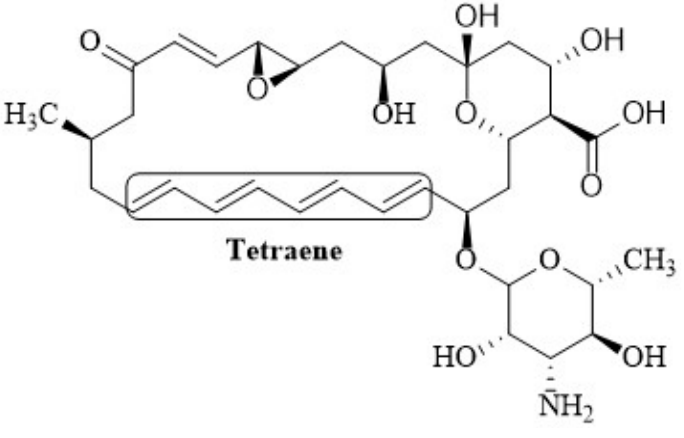
Figure 5. Structure of Natamycin 4 .